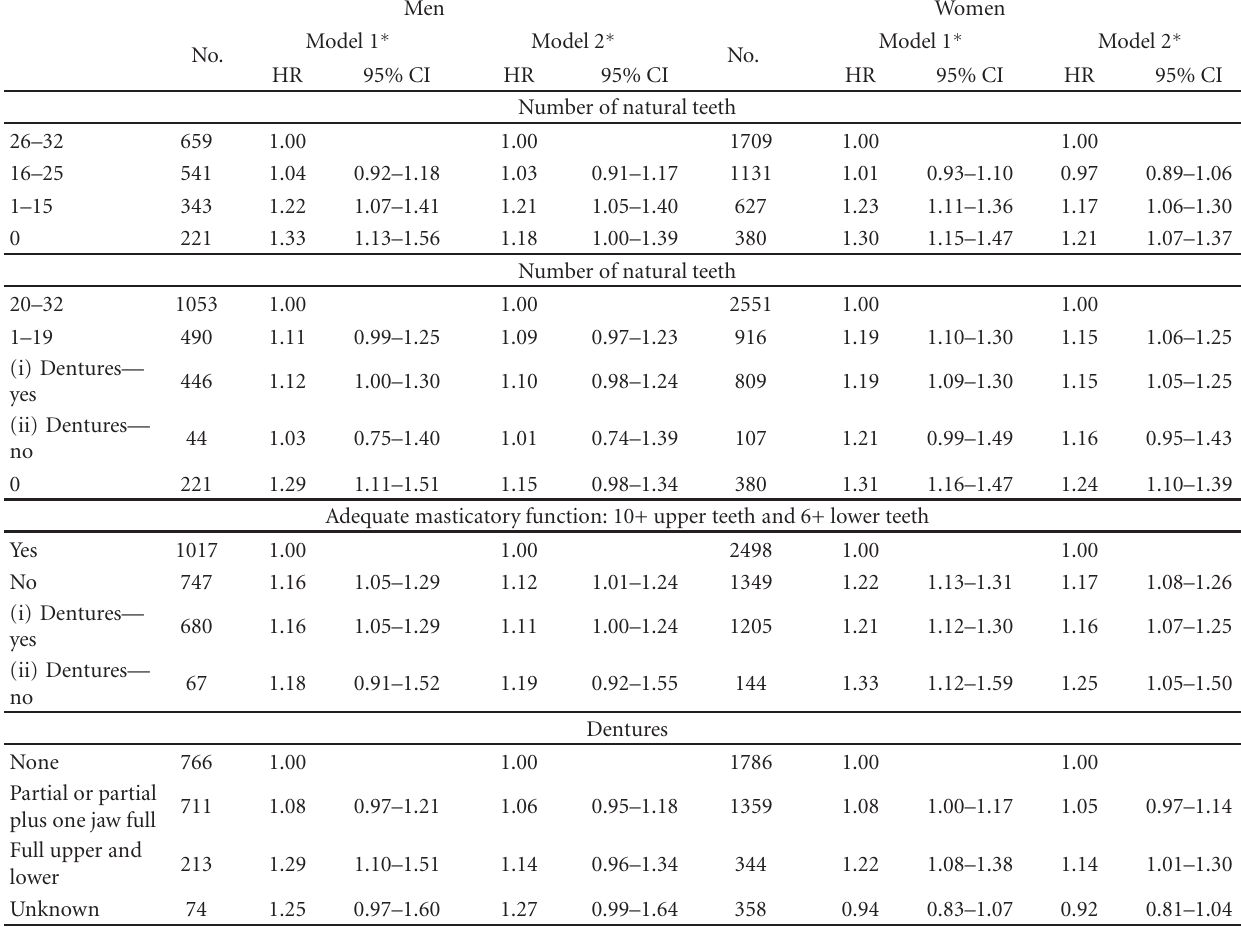
Table 2: Hazard ratios for mortality by dental status, Leisure World Cohort Study,